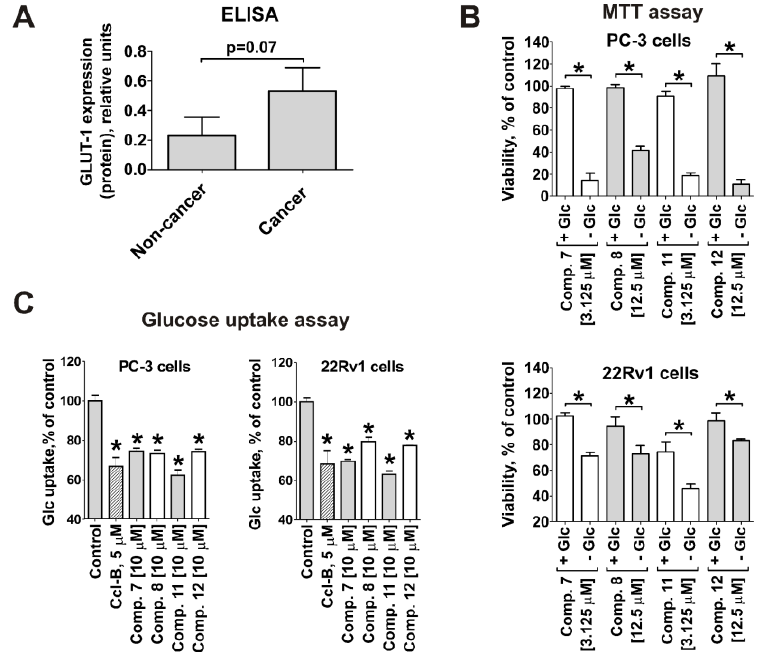
Figure 2. The correlation of cytotoxic activity of the synthesized compounds with cellular glucose uptake. ( A ) The expression of the glucose transporter 1 (GLUT-1) in five human prostate cancer cell lines versus five human non-cancer cell lines. The expression level was measured by ELISA. ( B ) Viability of PC-3 and 22Rv1 cells treated with the synthesized compounds at indicated concentrations in 10% FBS/RPMI media with or without 2 g/L glucose (Glc). The cytotoxic activity was measured by MTT test after 48 h of treatment and 12,000 cells/well. ( C ) Effect of the compounds on glucose uptake in PC-3 and 22Rv1 cells. Glucose uptake in viable (propidium iodide negative) cells was measured using 2-NBDG reagent and flow cytometry technique after 24 h of treatment. Cytochalasin B (Ccl-B, 5 µM) was used as positive control. In all the experiments cells were treated for 48 h. Statistical significance: * p < 0.05 (Student’s t -test, sections A and B ; or ANOVA followed by a post-hoc Dunnett’s test, section C ).